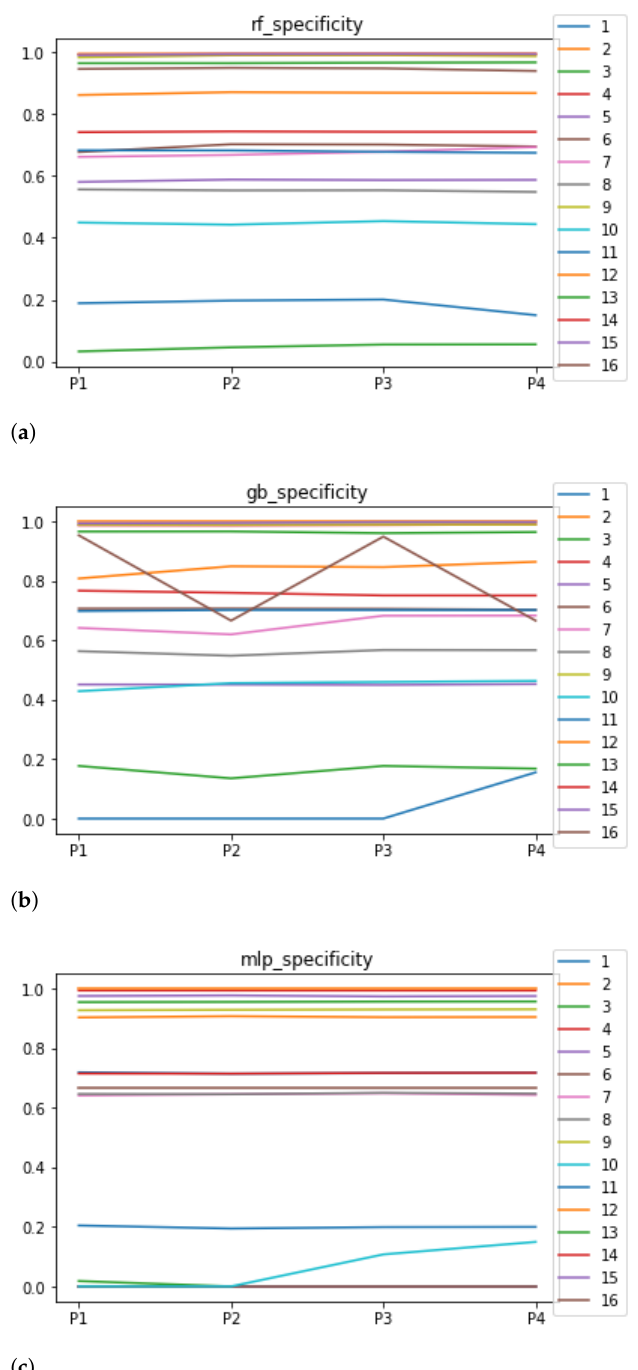
Figure 8. Behavior RHOASo: specificity. The datasets are represented with a bar chart for each partition. ( a ) Specificity for RF. Axis X: the partition of the dataset. Axis Y: the obtained specificity. ( b ) Specificity for GB. Axis X: the partition of the dataset. Axis Y: the obtained specificity. ( c ) Specificity for MLP. Axis X: the partition of the dataset. Axis Y: the obtained